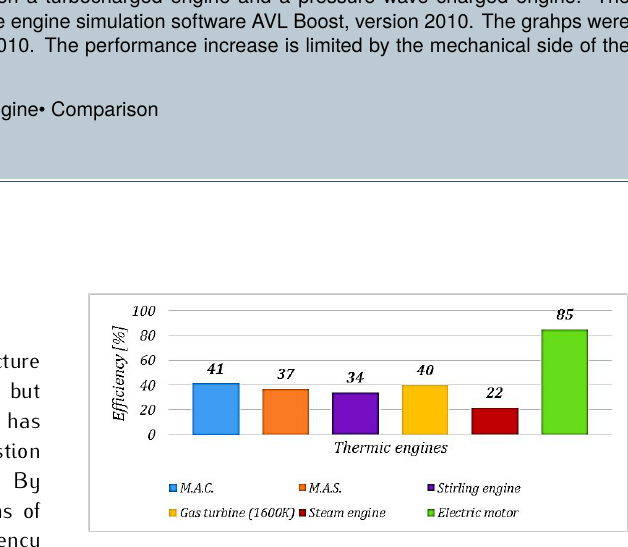
Figure 1. Thermic engine efficiency comparison.